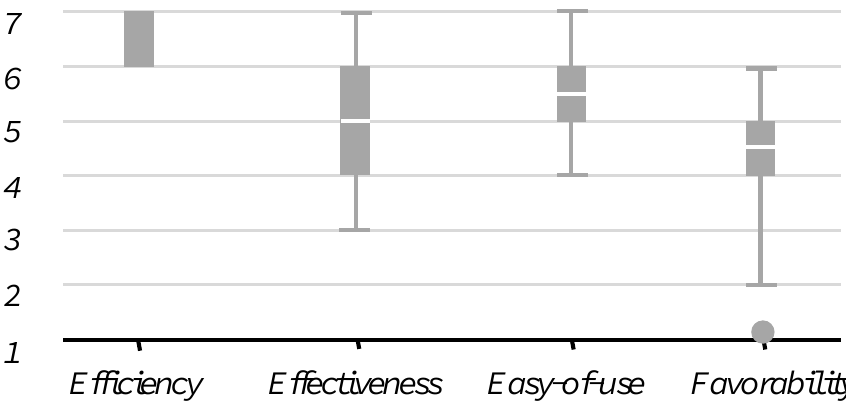
Figure 14. Scoring results on four